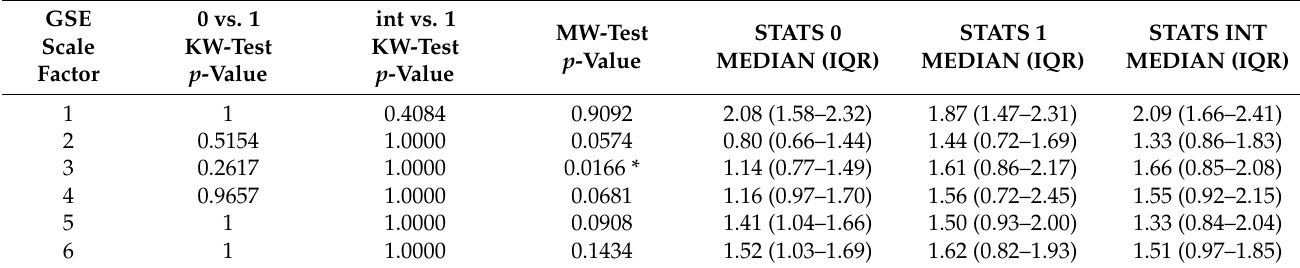
Table 3. Generalized Sample Entropy—statistical results of the test described in Section 2.6. The descriptive statistics (median and IQR) related to the three groups considered (0, 1, and int) are reported. Star (*) denotes statistically significant results.